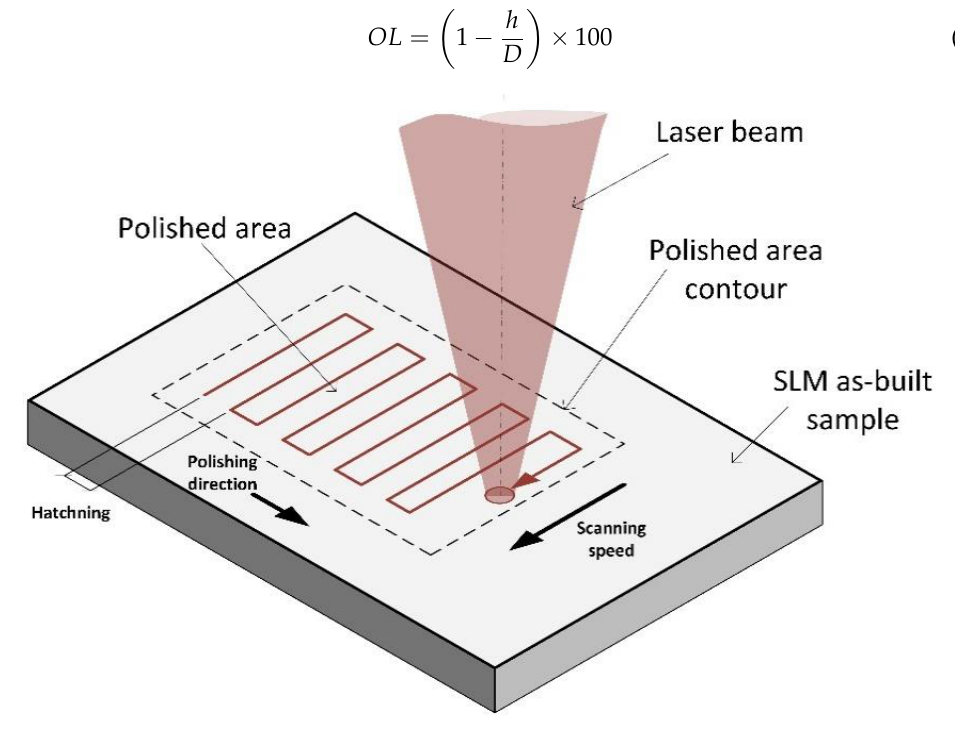
Figure 1. Zigzag strategy in context of laser polishing.